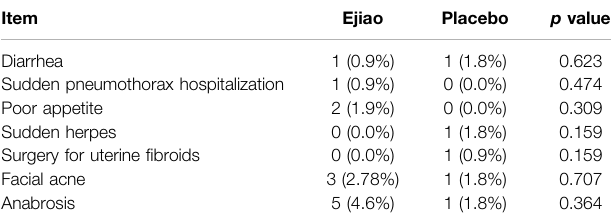
TABLE 5 | Summary of AEs. Item